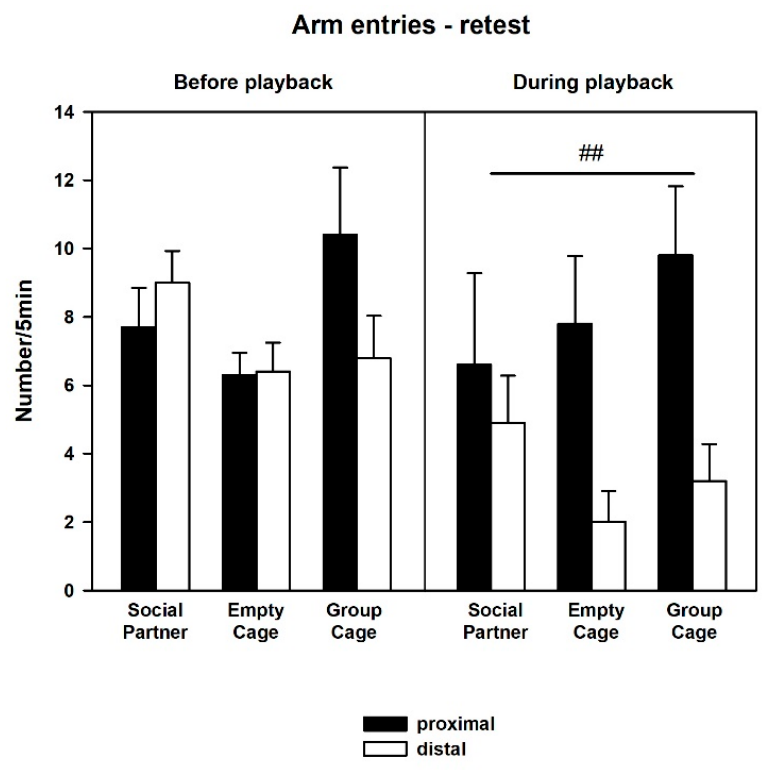
Figure 6. Proximal (black) or distal (white) arm entries in the retest before ( left ) or during ( right ) playback of 50-kHz USV in animals, which had access to a conspecific (Social Partner), no social contact (Empty Cage) or their cage mates (Group Cage) immediately after playback in the initial test. Data are presented as means + SEM. ## indicates a general difference ( p = 0.003) between proximal and distal values.